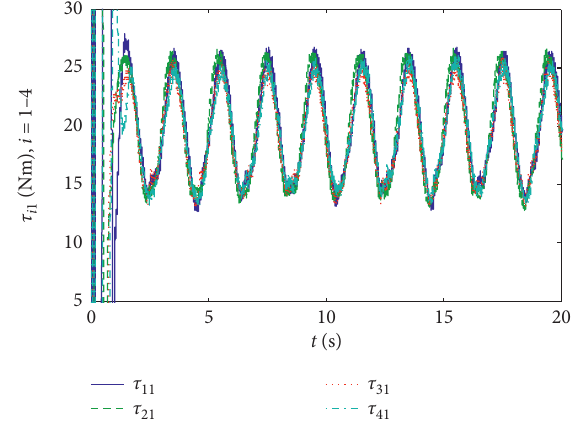
Figure 13: The control input torque τ